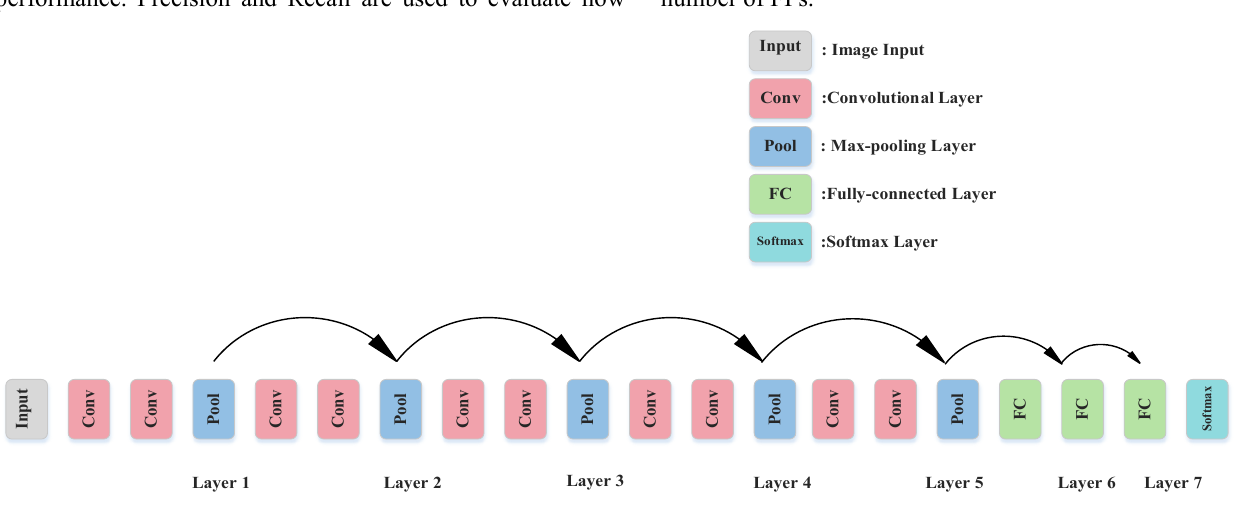
Fig. 5. VGG16 model architecture.